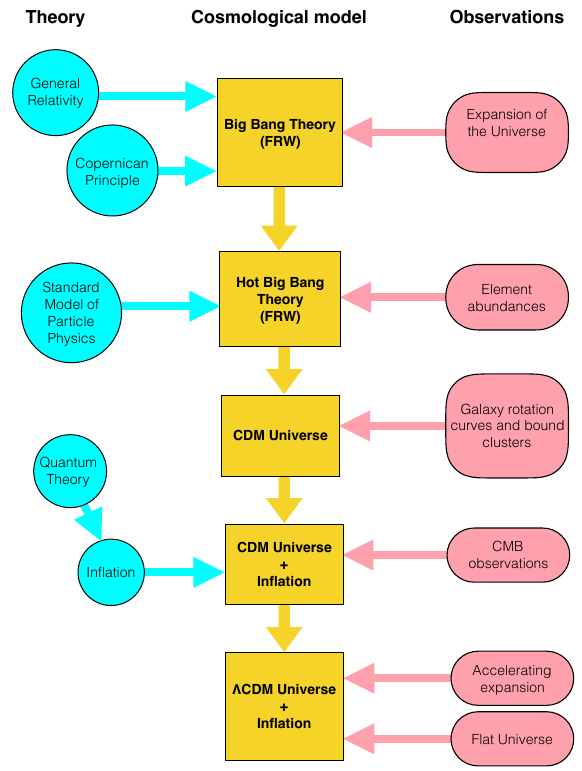
Figure 4. How the Concordance Model of Cosmology was developed. Theories and observations motivated the development of cosmological models, which were adjusted as new observations challenged the older